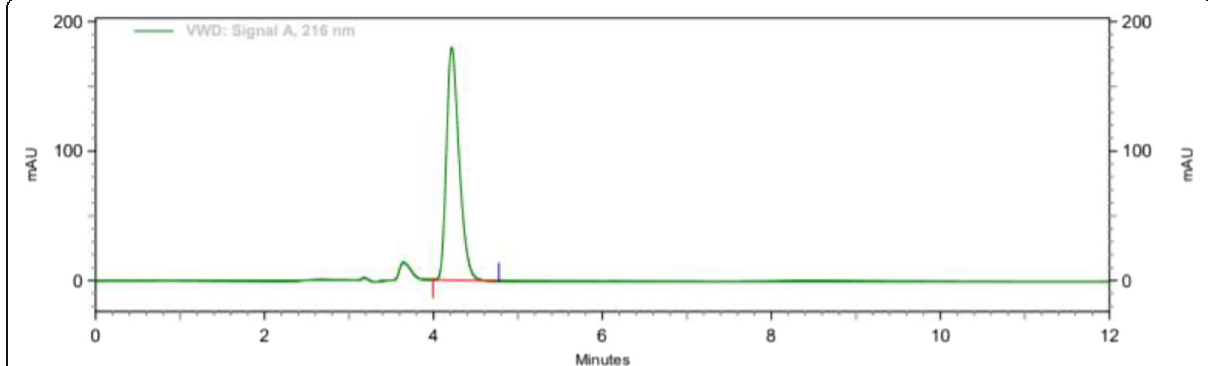
Fig. 5 Typical chromatogram of optimized